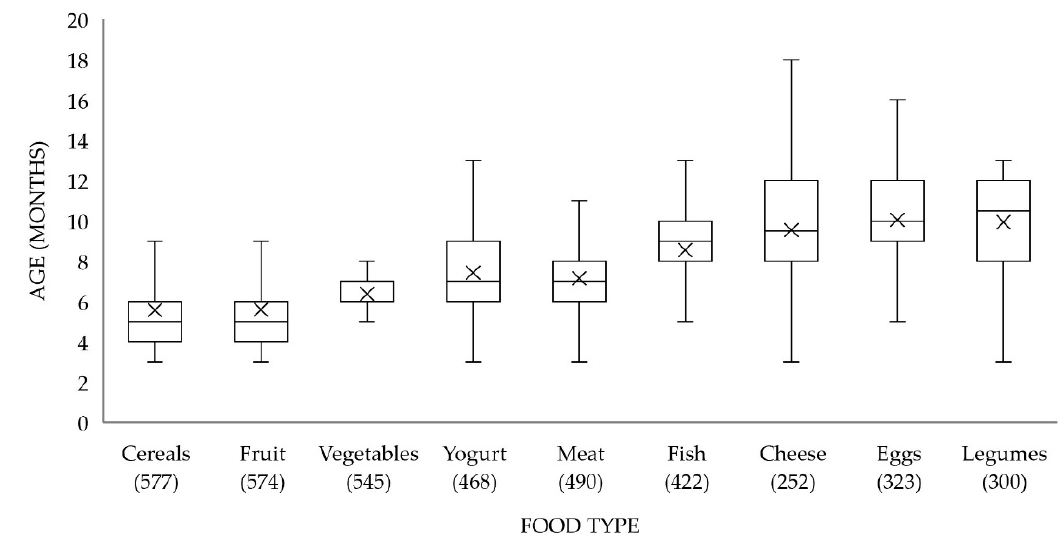
Figure 1. The age of introduction of each food category into the Spanish infants’ diets. The line in the boxplots represents the median and the cross represents the mean. The number between parentheses is the number of infants from the total sample that had already been introduced to the corresponding food category.